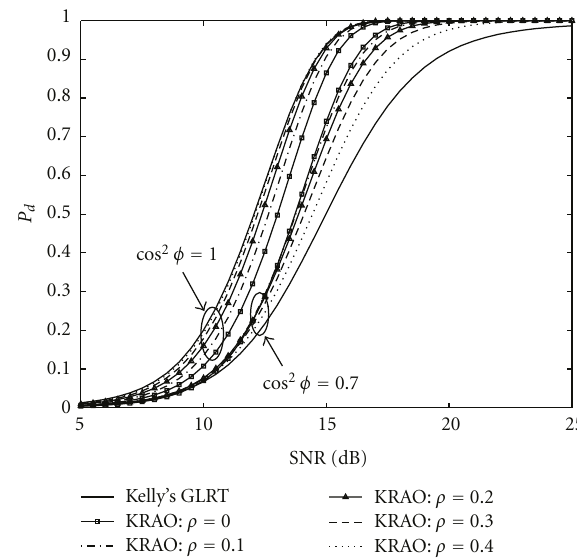
Figure 2: P d versus SNR for the KRAO, N = 8, K = 24, and ρ ≥ 0 . 5. and the rejection performance. So the appropriate value of ρ is selected based on the system needs.